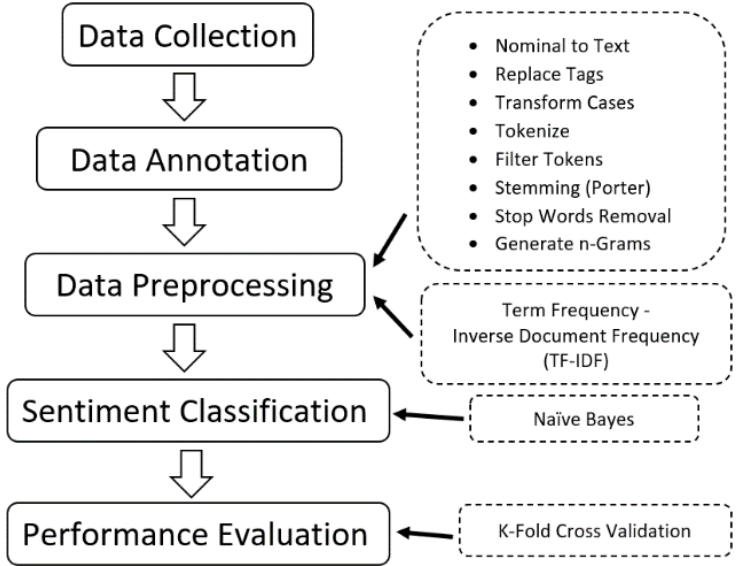
Figure 1. This figure presents the five phases of this study: data collection, data annotation, data preparation, sentiment classification, and performance evaluation.